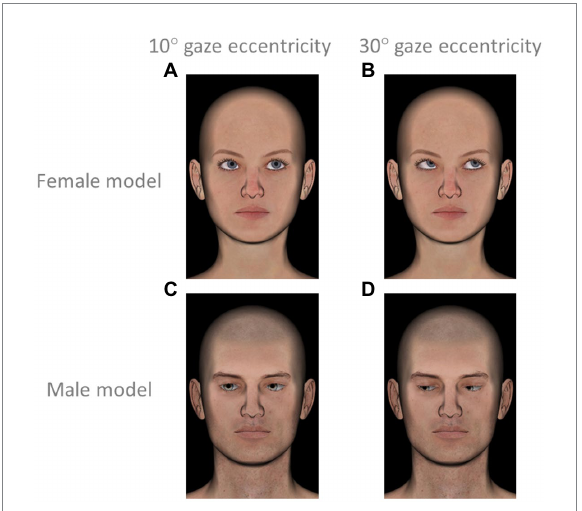
FIGURE 3 Examples of stimuli presented in Experiment 1b. (A) female face with gaze at low eccentricity (direction 45 ° , up left); (B) female face with gaze at high eccentricity (direction 45 ° , up left); (C) male face with gaze at low eccentricity (direction 225 ° , down right); (D) male face with gaze at high eccentricity (direction 225 ° , down